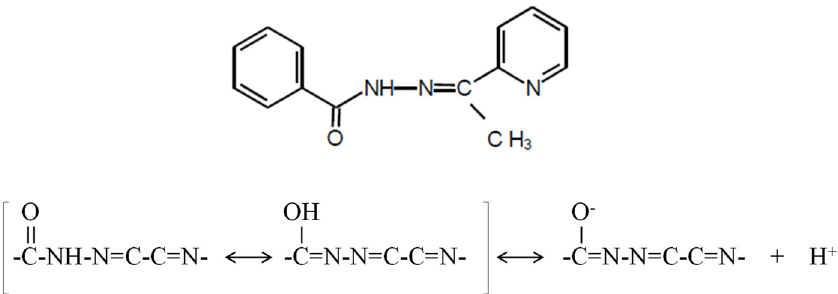
Figure 1. The chemosensor 2-acetylpyridine benzoylhydrazone (2-APBH) and its tautomeric struc- tures [49].